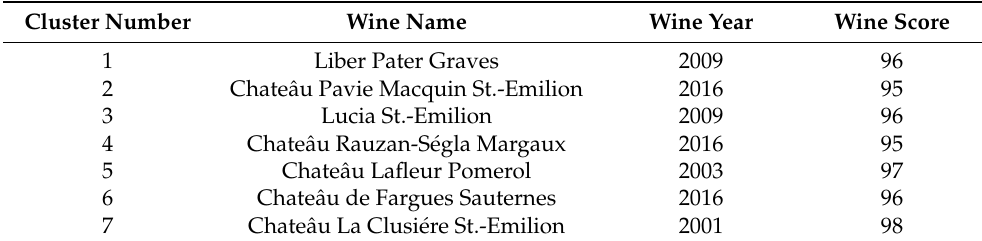
Table 6. Wines closest to each centroid. These wines (with the exception of Cluster Number 1) best reflect the clusters formed from the elite